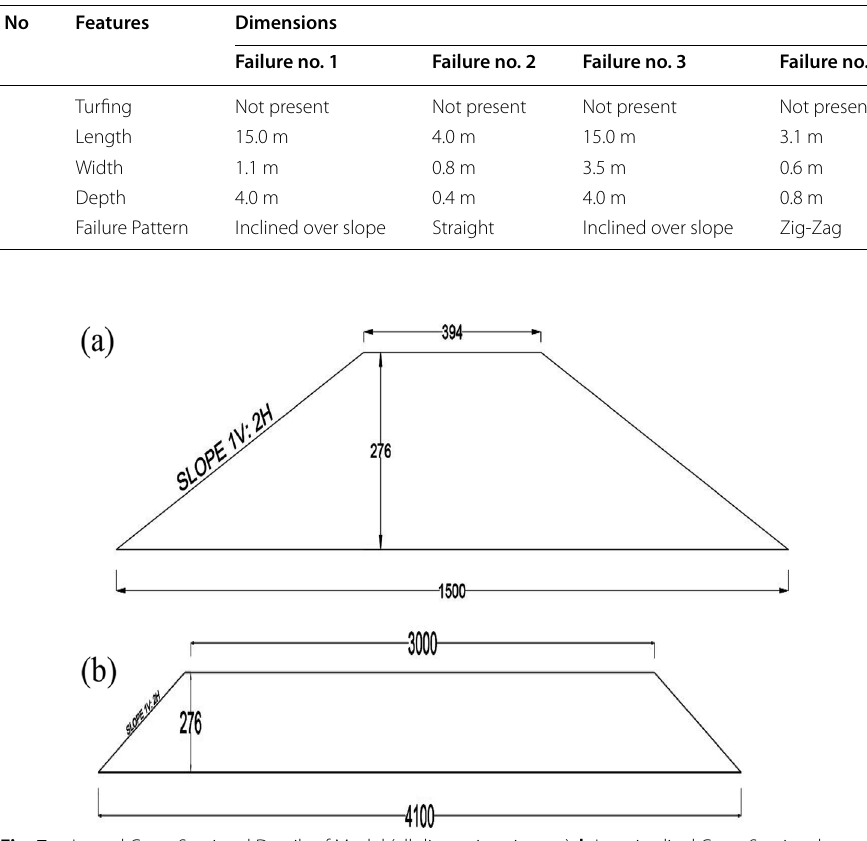
Fig. 7 a Lateral Cross-Sectional Details of Model (all dimensions in mm). b Longitudinal Cross-Sectional Details of Model (all dimensions in